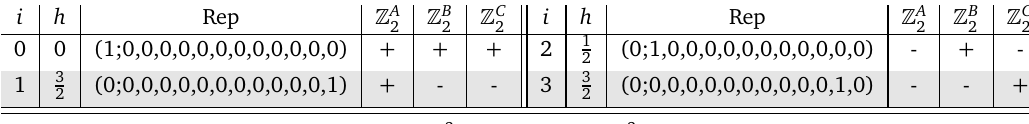
, (cid:90) B , (cid:90) C , 2 2 2 × (cid:90) . 2 2